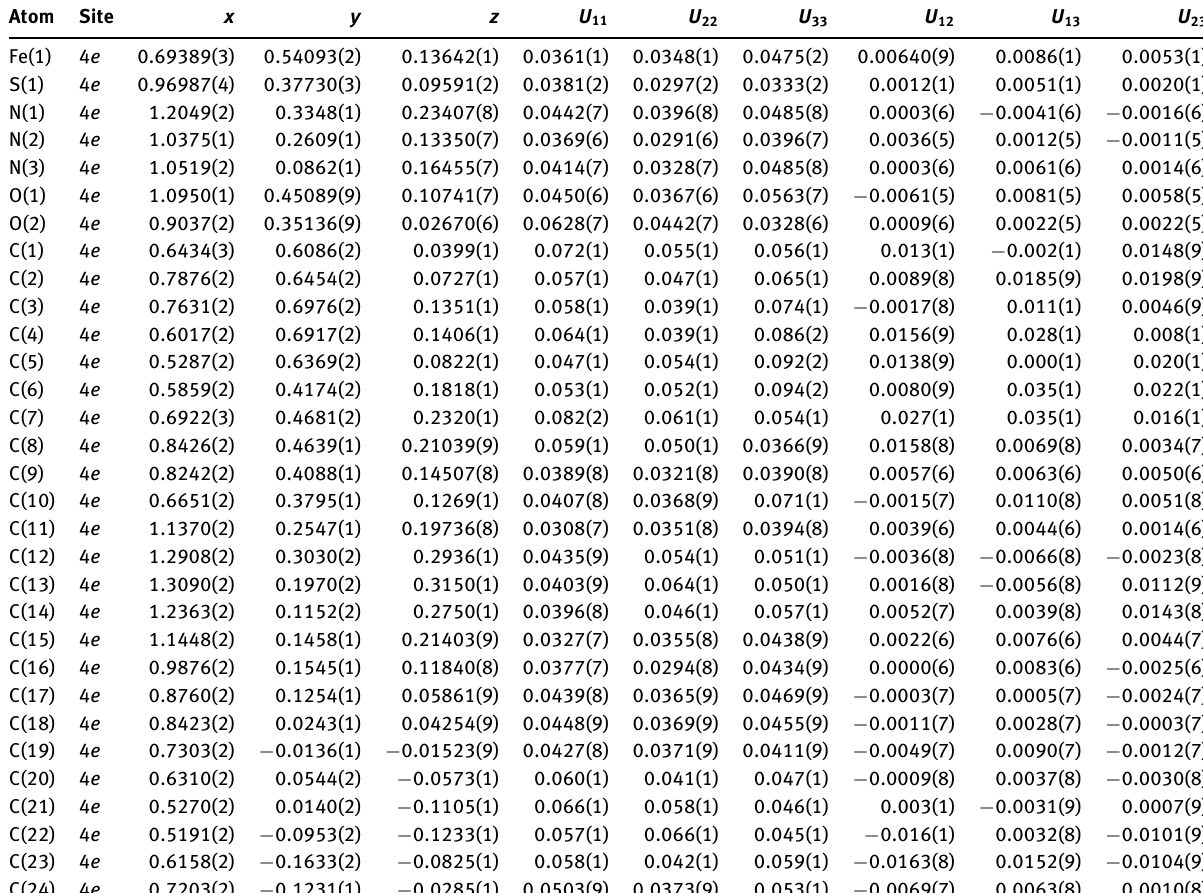
Table 3: Atomic displacement parameters (Å 2